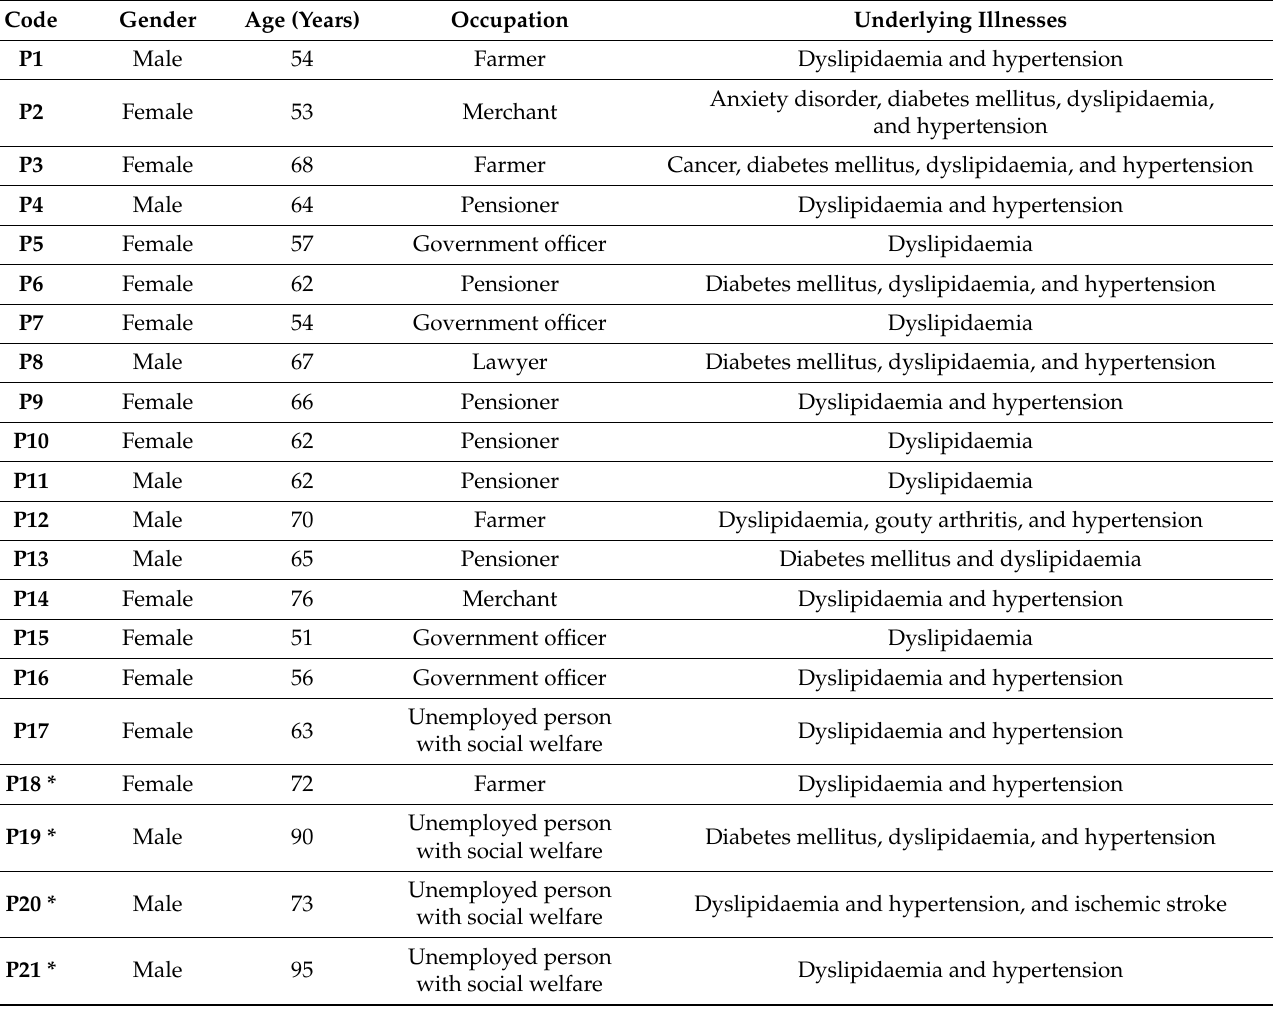
Table 2. Patient characteristics.